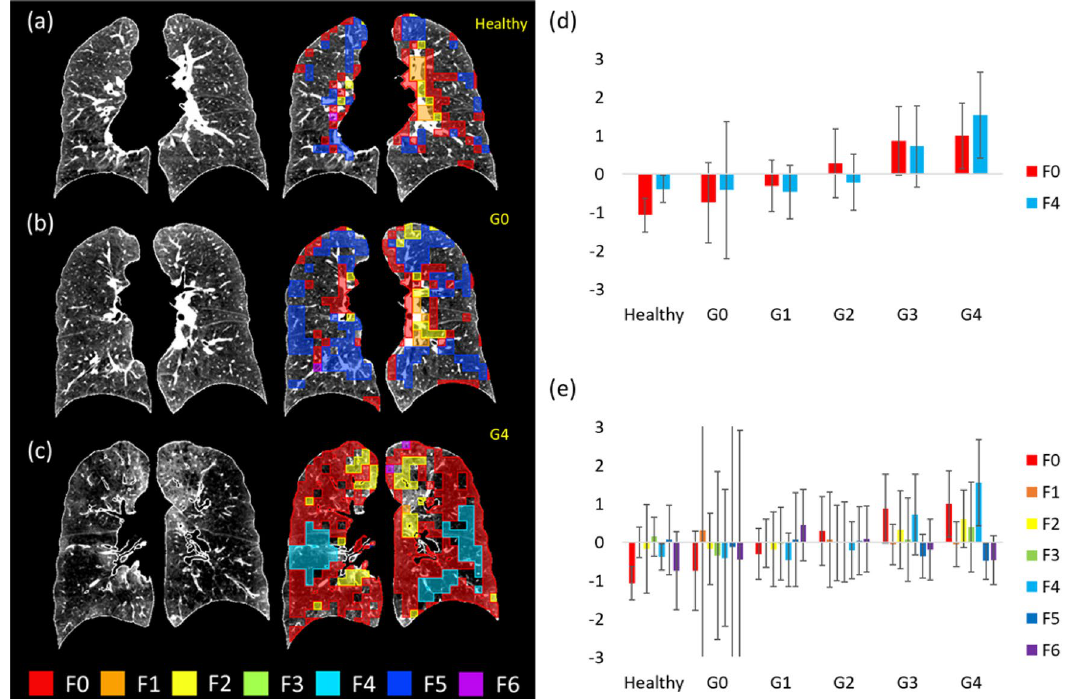
Figure 6. ( a ) The original TLC image (left) and the color-coded image (right) of a healthy non-smoker (FEV 1 / FVC = 79.02%, FEV 1 % predicted = 81.47%) whose factor scores of F0 and F4 are the closest to the means of the healthy non-smoker cohort. ( b ) The original TLC image (left) and the color-coded image (right) of a GOLD 0 subject (FEV 1 /FVC = 56%, FEV 1 % predicted = 97.88%) whose factor scores of F0 and F4 are the closest to the means of the GOLD 0 subjects. ( c ) The original TLC image (left) and the color-coded image (right) of a GOLD 4 subject (FEV 1 /FVC = 29.21%, FEV 1 % predicted = 20.05%) whose factor scores of F0 and F4 are the closest to the means of the GOLD 4 subjects. The images are plotted in a posterior–anterior view. ( d ) The averaged factor scores of F0 and F4 for the healthy non-smokers, and GOLD 0–GOLD 4 subjects. ( e ) The variations of the factor scores for the GOLD 0 subjects are the largest among all subgroups, implying the heterogeneous nature of the subjects at